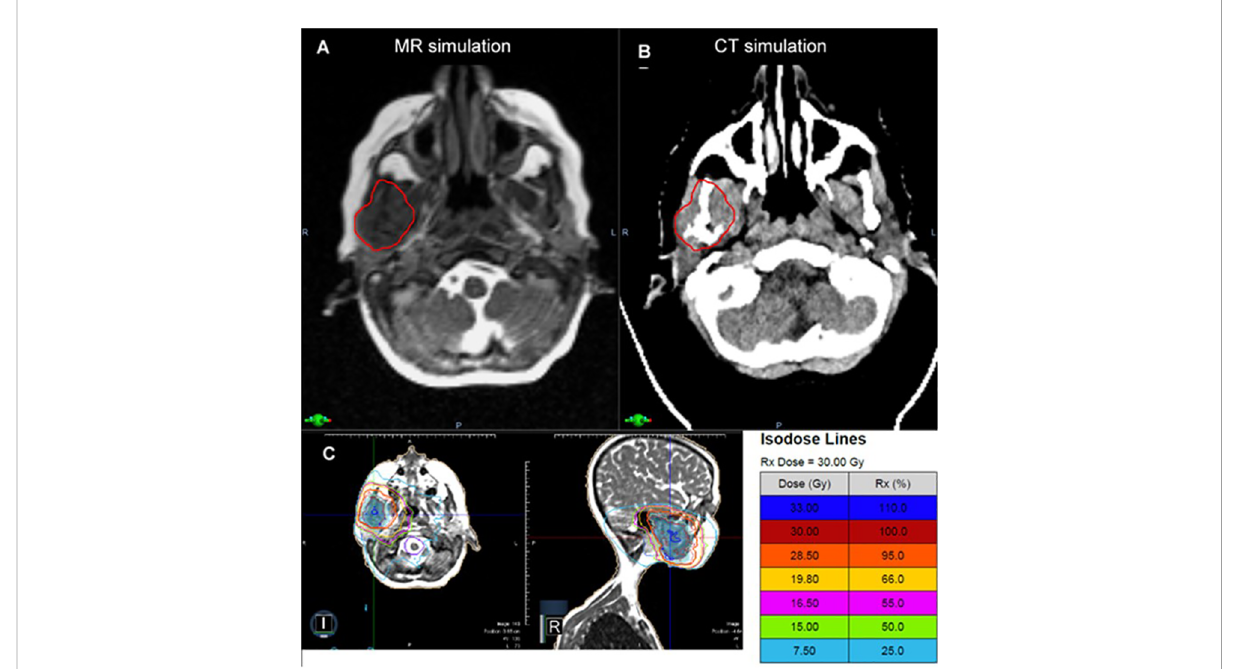
FIGURE 3 In a patient with metastatic neuroblastoma involving the mandible, the MR simulation (A) provided superior visualization of the tumor relative to the adjacent masseter and pterygoid muscles compared to CT (B) . The patient was treated with a 3D conformal MRgRT plan (C) , which provided favorable sparing of the oral cavity and the ipsilateral and contralateral salivary glands with similar plan quality to